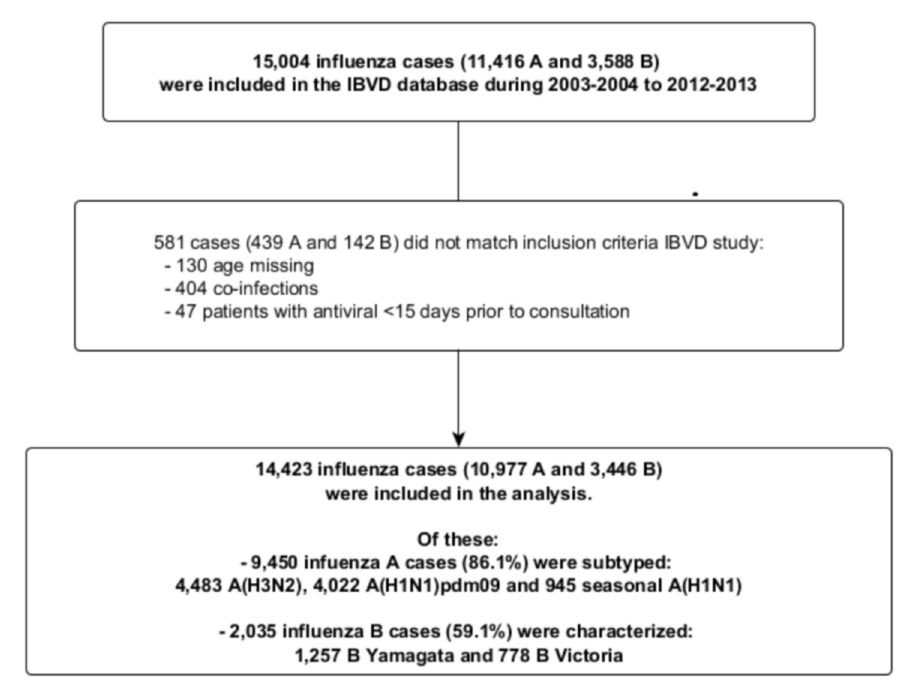
Fig 1. Flow chart of the influenza A and B patients included in the IBVD (Influenza B in Vircases Database) study.